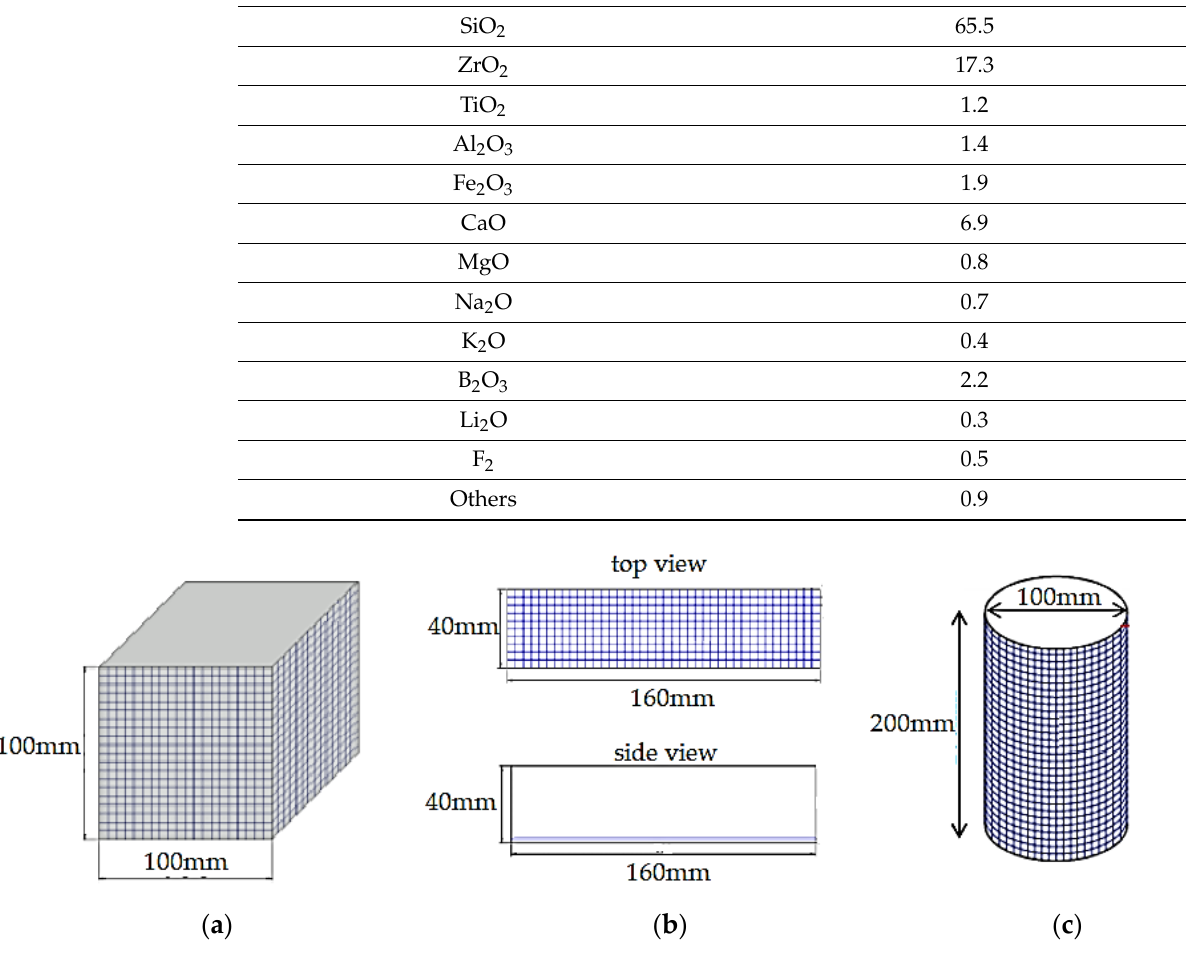
Figure 2. Position of the fibermesh confining foamcrete. ( a ) compression test ( b ) flexural test ( c ) tensile test.